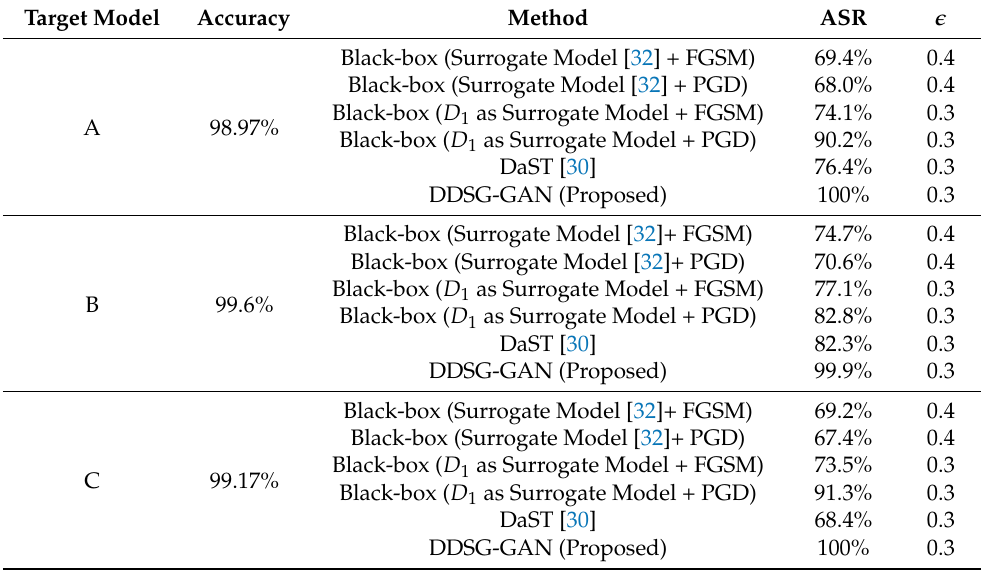
Table 4. Experimental results of untargeted attack under l ∞ norm (ASR: the attack success